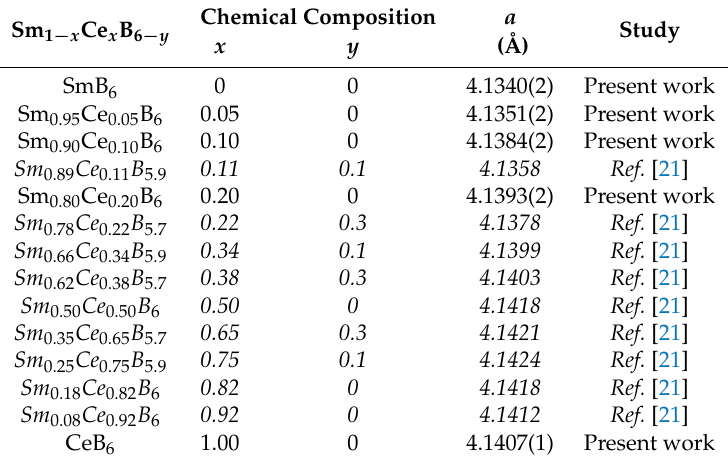
Table 1. Lattice parameters calculated from profile matching the powder X-ray diffraction patterns of the Sm 1 − x Ce x B 6 ( x = 0.05, 0.10 and 0.20) crystals to the Pm 3 m cubic structure. The previously reported structural parameters quoted for other members of the Sm 1 − x Ce x B 6 − y series [21] are included for